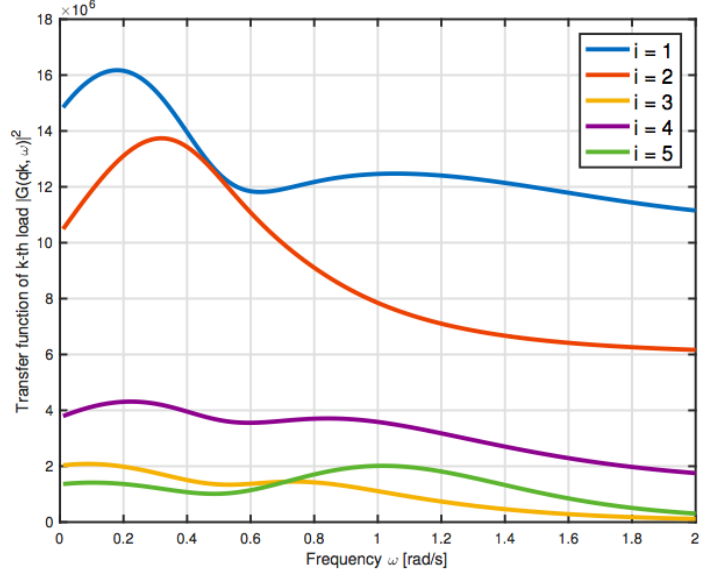
Figure 5. Wave transfer functions for the 5DOF